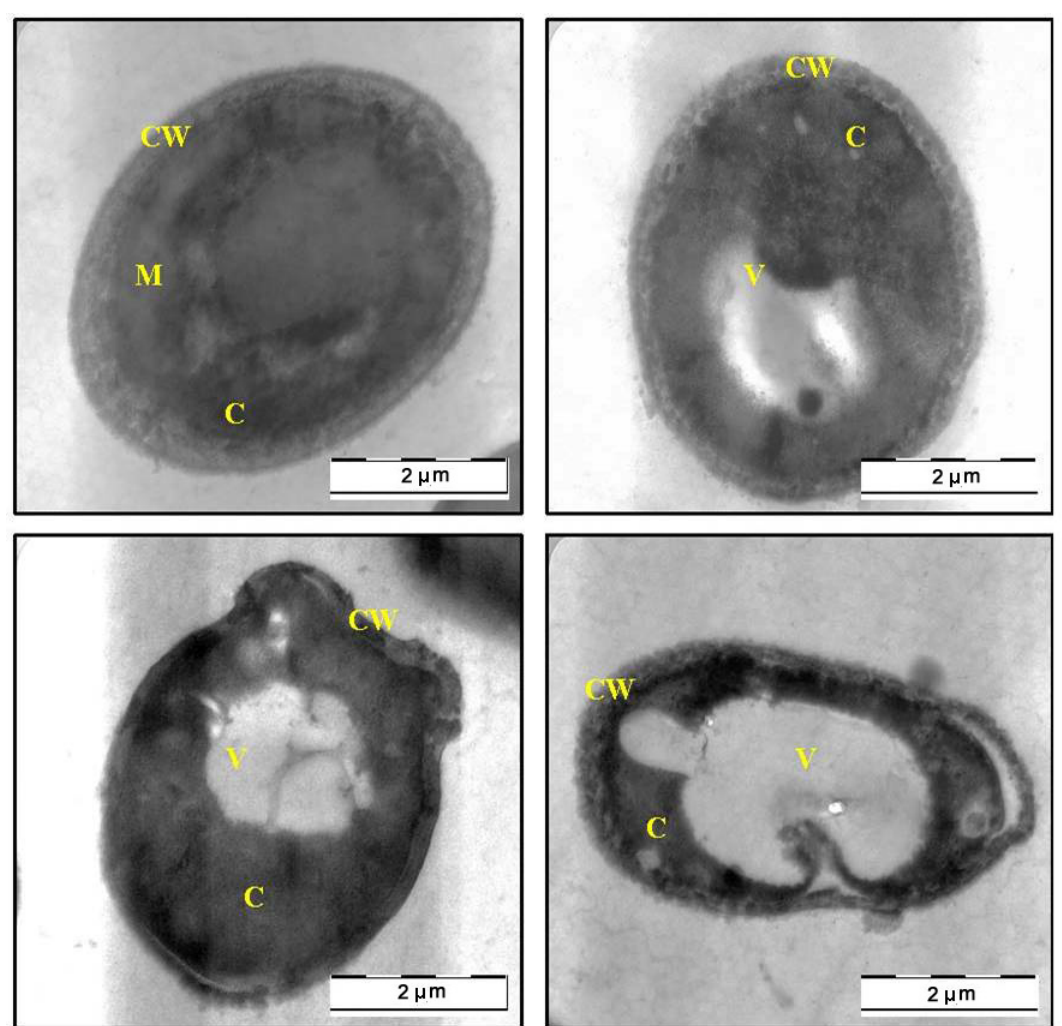
Figure 5. TEM micrograph of a cross-section of the extract treated cell of Candida albicans after 24 h (C: Cytoplasm; CW: Cell Wall; M: Mitochondria; V: